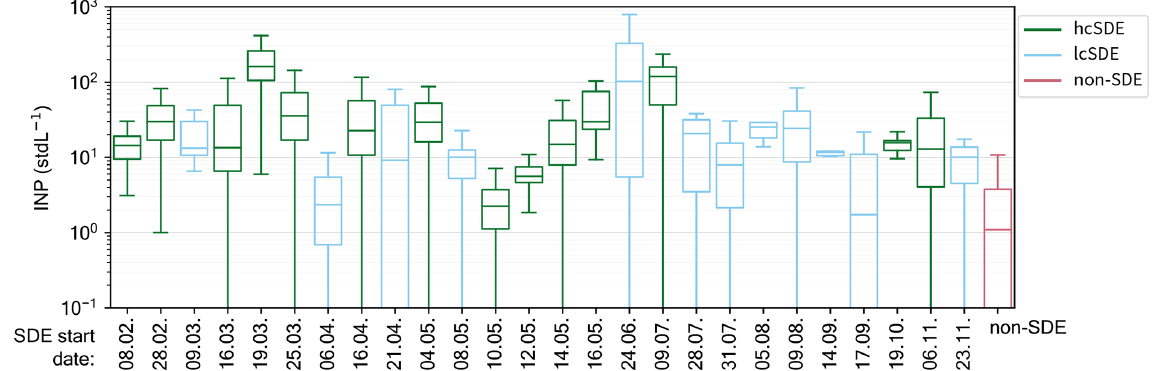
Figure 5. Box plots from all 26SDEs, color-coded as high-confidence SDEs (hcSDE) or low-confidence SDEs (lcSDE), respectively, and the non-SDE periods: median with 25th to 75th percentiles; whiskers: 5th to 95th percentiles.